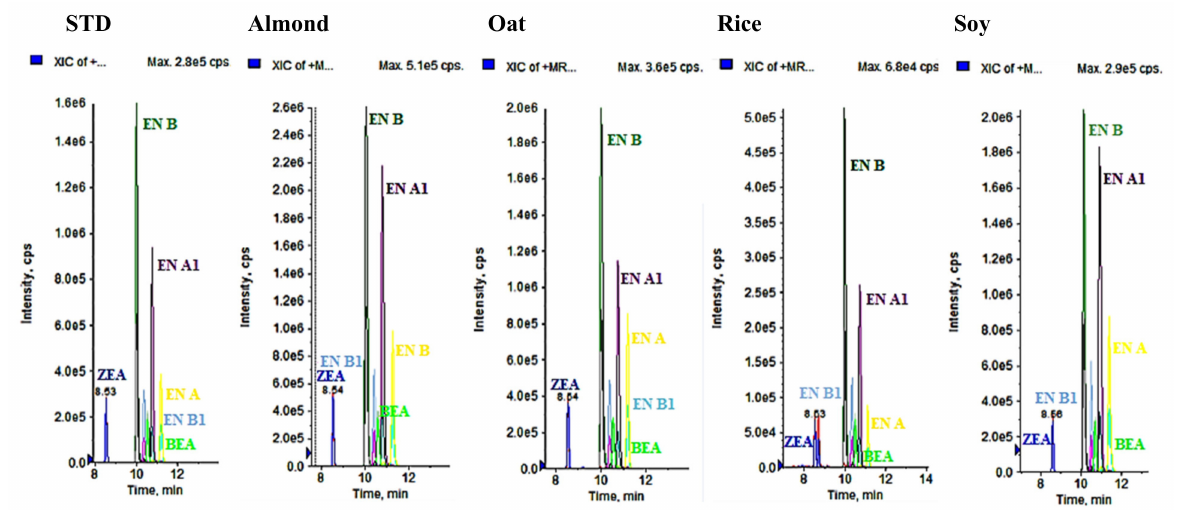
Figure 2. Chromatograms ENA, ENA1, ENB, ENB1 and ZEA standard solution (STD) and matrix of almonds, oats, rice and